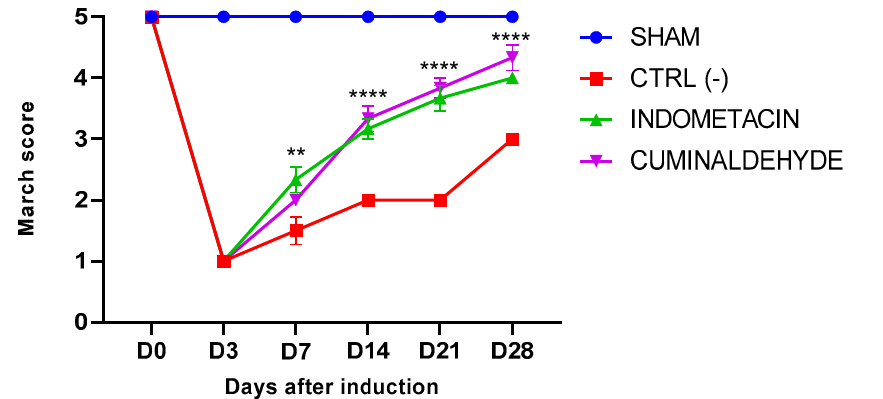
Figure 1. Effects of cuminaldehyde on the motor activity/forced ambulation of rats with induced OA, evaluated using the Rotarod test score. The animals were administered oral saline (CTL − ), indometacin (CTL+), and cuminaldehyde (50 mg/kg) from D3 to D28, and were evaluated on days 7, 14, 21, and 28, after OA induction. Data are represented as means ± standard error of the means (SEM). The SHAM group represents animals without osteoarthritis and without any treatment. The statistical analysis was performed using two-way ANOVA followed by Tukey’s test. Significant differences were denoted by ** at p < 0.001 and **** at p < 0.0001. (D = day).